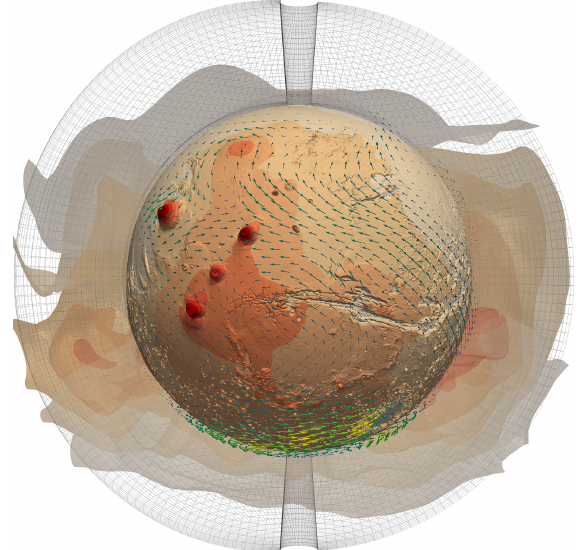
Figure 1. Overview three-dimensional plot of example output dur- ing Southern Hemisphere summer ( L s = 260 ◦ ). Included is a seg- ment of the extracted regional dust layer as an isosurface, wind vec- tors at 1km height (arrows) and orography. Grid cells are cropped to 30km. Higher-resolution GIF and code are available at https: //github.com/dannymcculloch/3d_Mars_gif (last access: 16 Jan- uary 2023). Made with PyVista (Sullivan and Kaszynski,